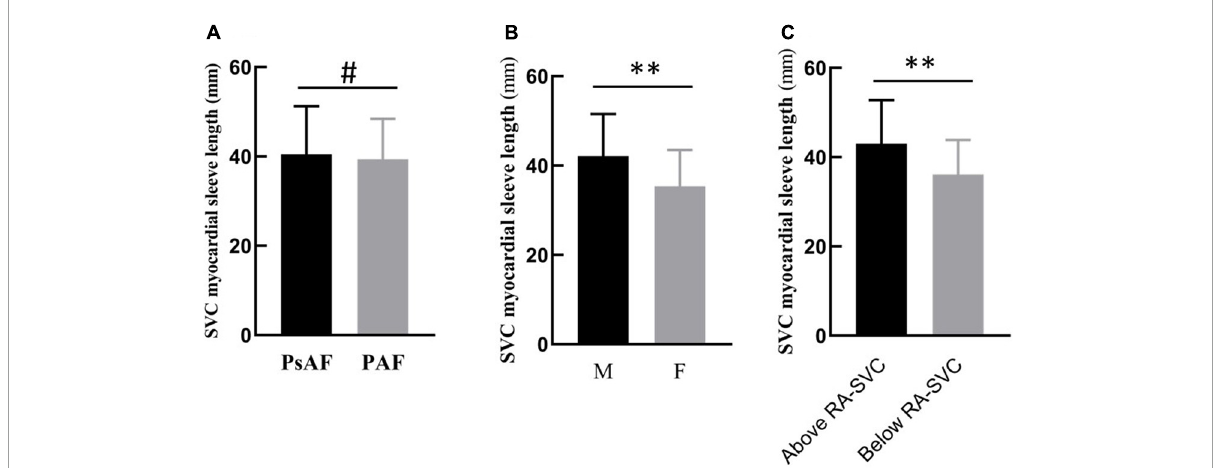
FIGURE2 Subgroup analysis of LSVC in patients with atrial fibrillation (AF). (A) There was no difference between PAF and PsAF. (B) The length of the myocardial sleeve in men was longer than in women. (C) When the location of SAN was above the RA-SVC junction, the length of the SVC myocardial sleeve was longer than that below the junction. PAF, paroxysmal atrial fibrillation; PsAF, persistent atrial fibrillation; M, male; F, female; RA, right atrium; SAN, sinus node; SVC, superior vena cava, # p > 0.05; ** p < 0.01.